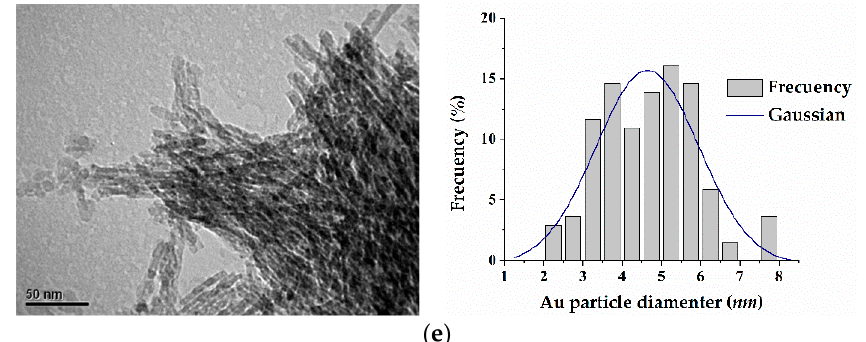
Figure 3. TEM micrographs and Au NPs size distribution of the as-synthesized supports and catalysts. ( a ) ANW; ( b ) ANW-NH 2 ; ( c ) 0.25Au/ANW; ( d ) 0.50Au/ANW and ( e ) 1.00Au/ANW.